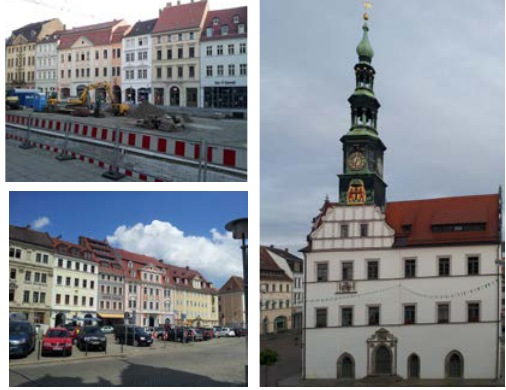
Figure 1. Façade restoration work in the German cities of Zittau (upper left), Görlitz (lower left), and Pirna